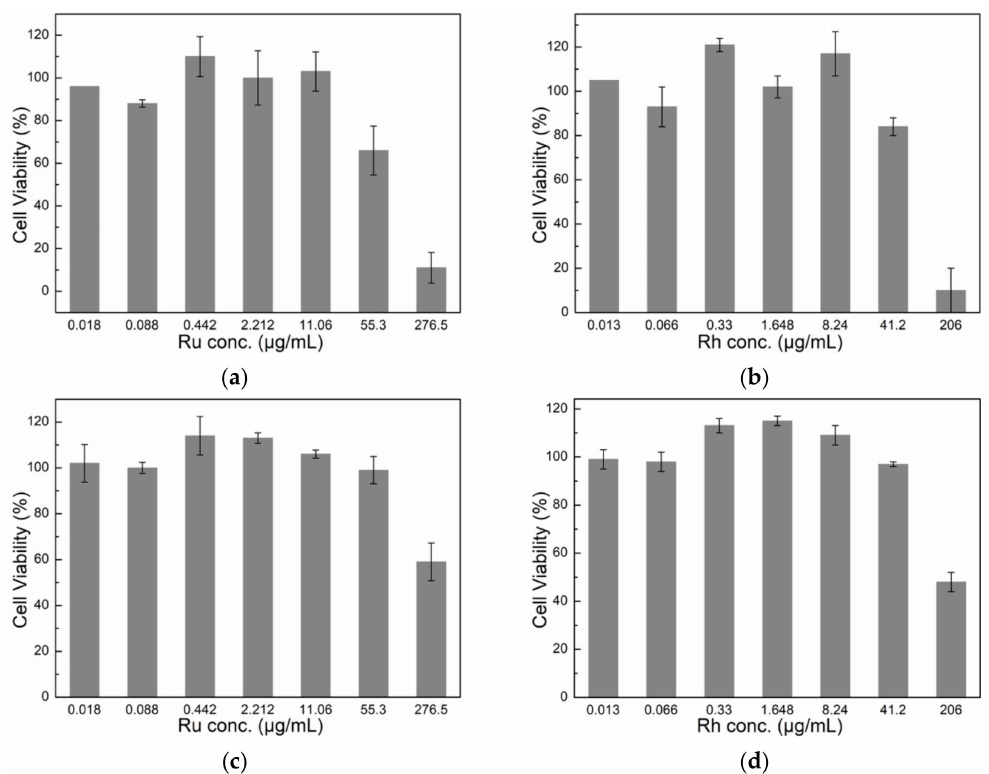
Figure 7. CCK-8 based cytotoxicity assay of Ru and Rh NPs in ( a , b ) murine macrophages (RAW 264.3) and ( c , d ) human-derived ovarian cancer cells (SKOV-3). The percentage of cell viability is calculated taking negative control cells incubated in the absence of NPs with 100%